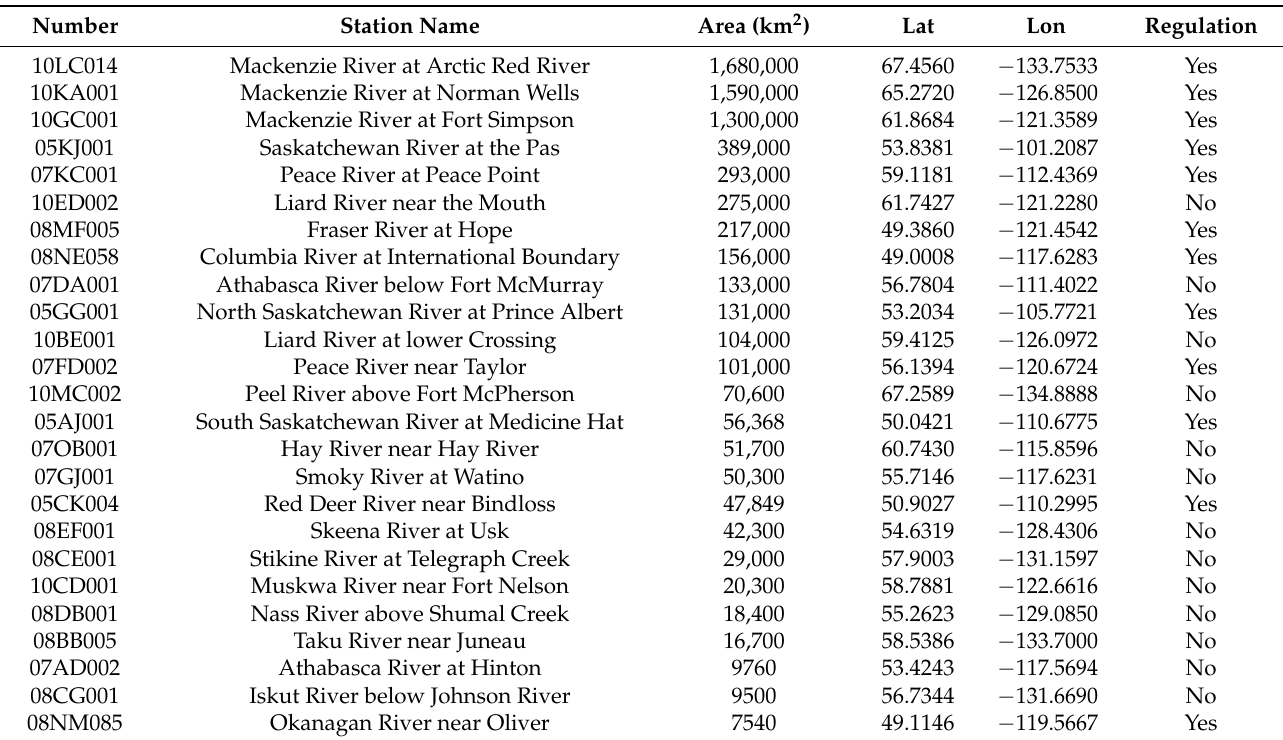
Table 1. Hydrometric stations across western Canada used for annual maximum and mean spring flow analysis and MLR